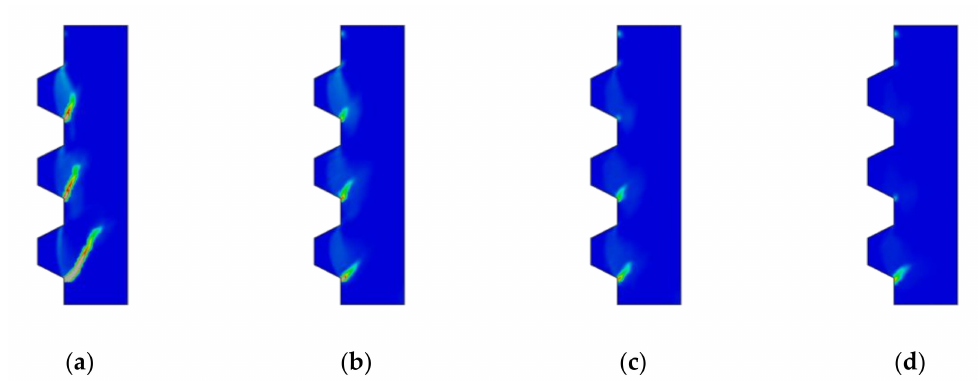
Figure 12. Crack pattern evolution in a 3-keyed joint with σ n = 1.5 MPa: ( a ) V f = 0.0%; ( b ) V f = 0.5%; ( c ) V f = 1.0%; ( d ) V f =